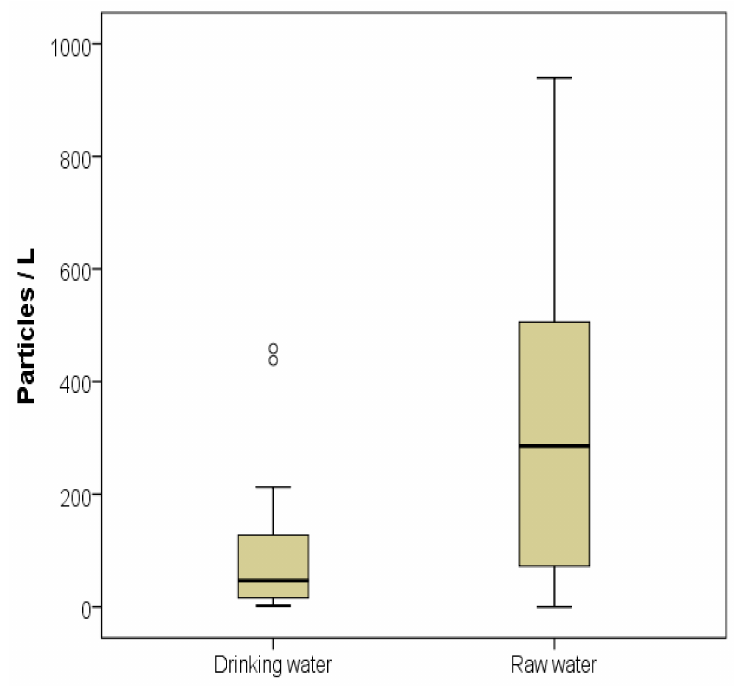
Figure 2. Box and whisker plot showing median (black line), total range (whiskers), the inter-quartile range (grey box), and outliers (dots) of MP particle concentrations in samples of drinking and raw water in the Sinos River basin.